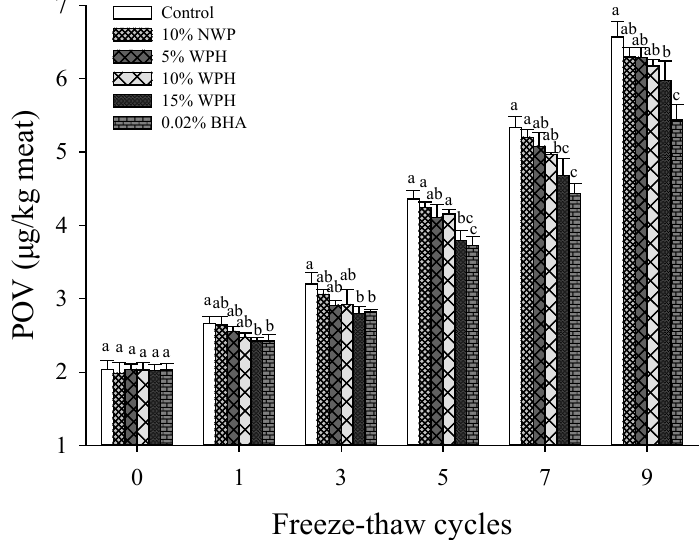
Figure 1. Changes in peroxide value (POV) of multiple freeze–thaw (F–T) cycles of pork patties with different whey protein hydrolysate (WPH) contents. The significant differences among different samples are indicated by different lowercase letters (a–c). Control: without any additives in the sample; NWP: native whey protein; BHA: butylated hydroxyanisole.